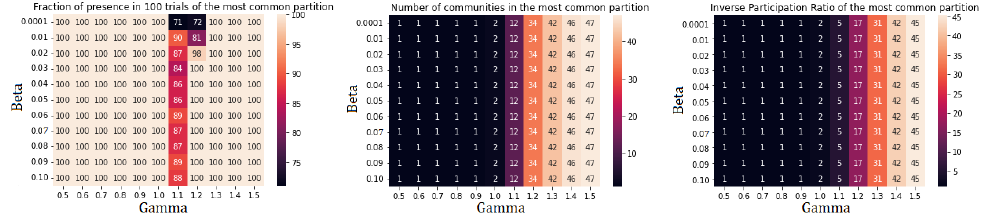
Figure A7. Performance indicators for Leiden algorithm applied to community 0. Two subcommuni- ties are found: community I (22 nodes) and community II (27